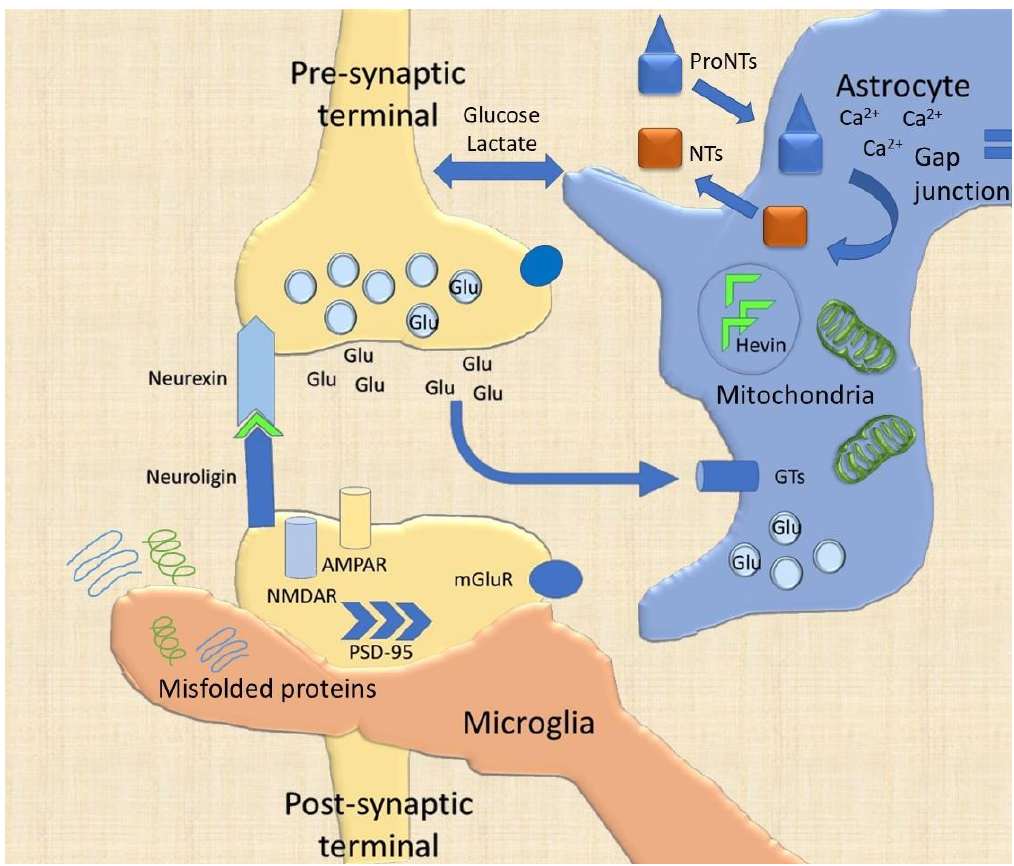
Figure 2. Cellular elements in the synaptic cleft. The schematic representation of a glutamatergic synapse highlights the role of molecular pre-synaptic (neurexins), post-synaptic (neuroligin) proteins and the astrocytic hevin in the stabilization of the cleft structure. The reuptake of neurotransmitters by glutamate transporters (GTs) is mainly provided by astrocytes. Moreover, astrocytes are responsible for the proneurotrophins (proNTs) alternative intracellular processing to active NTs and the metabolic coupling. The synaptic plasticity phenomena are widened by the astrocytic calcium waves, ensured through gap junction and by microglial trogocytosis (the partial engulfment of dendritic spines or axonal portions). The scavenger role of microglia is nonetheless necessary to avoid waste accumulation and synaptic failure.